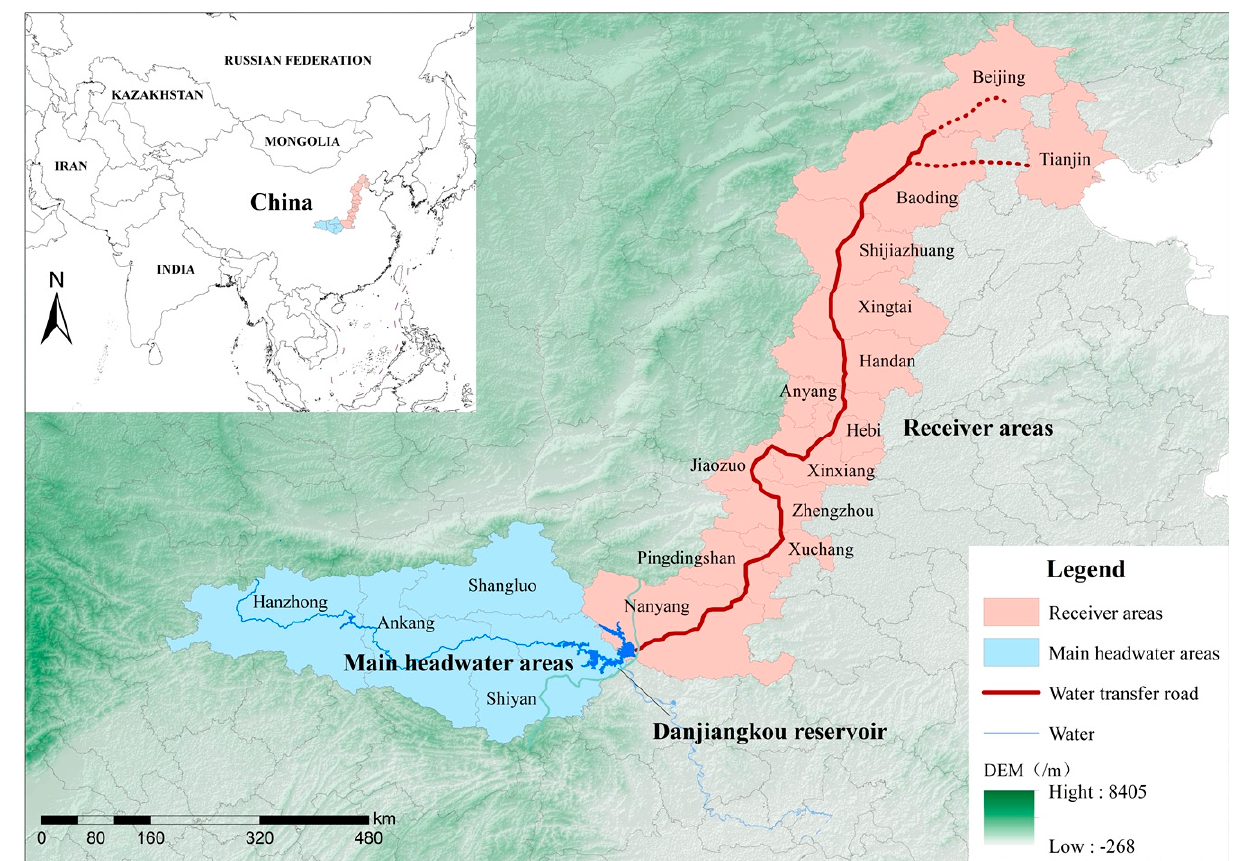
Figure 1. The location of the target study area.